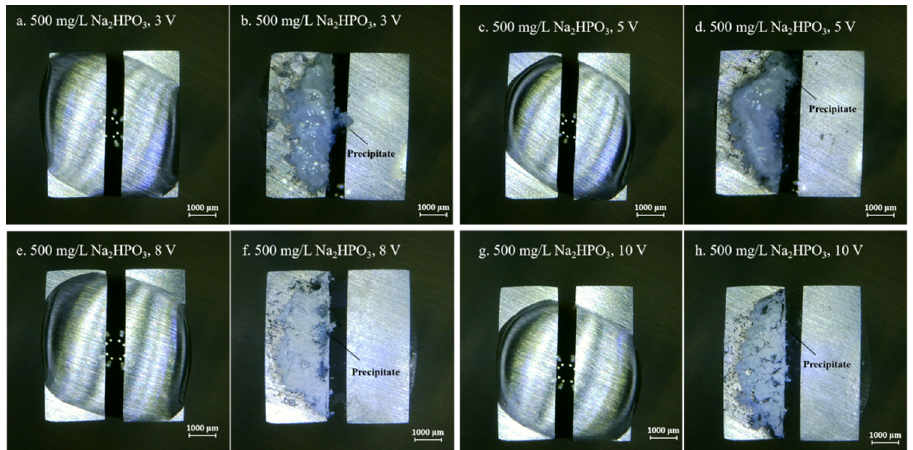
Figure 6. Optic photos for ECM tests of tin under a droplet of 15 μ L containing 100 mg/L Na 2 HPO 4 at various bias voltages (Anode is on the left and cathode is on the right). Metals 2020 , 10 , x FOR PEER REVIEW